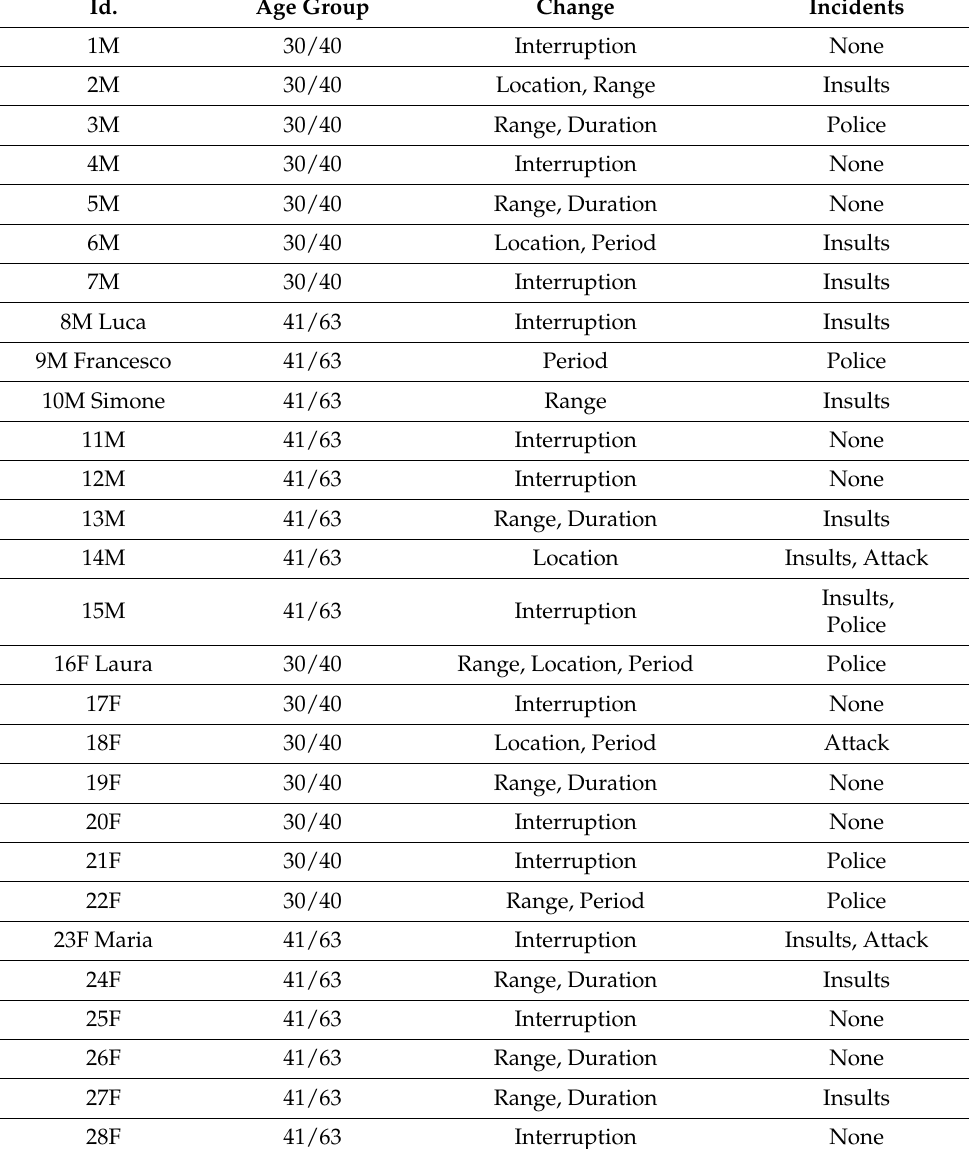
Table 1. Summary of the impact of the lockdown on the jogging practices of the informants.